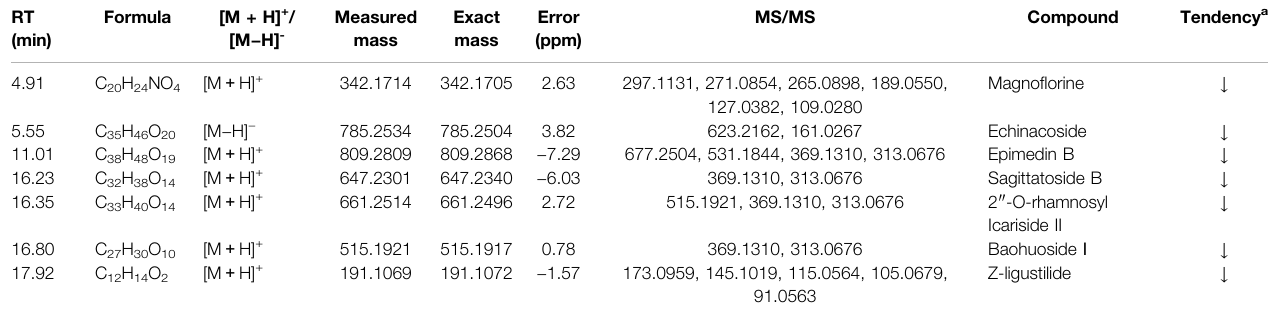
TABLE 1 | Identi fi cations of the highlighted ions which were validated by reference standards. RT Formula (min)